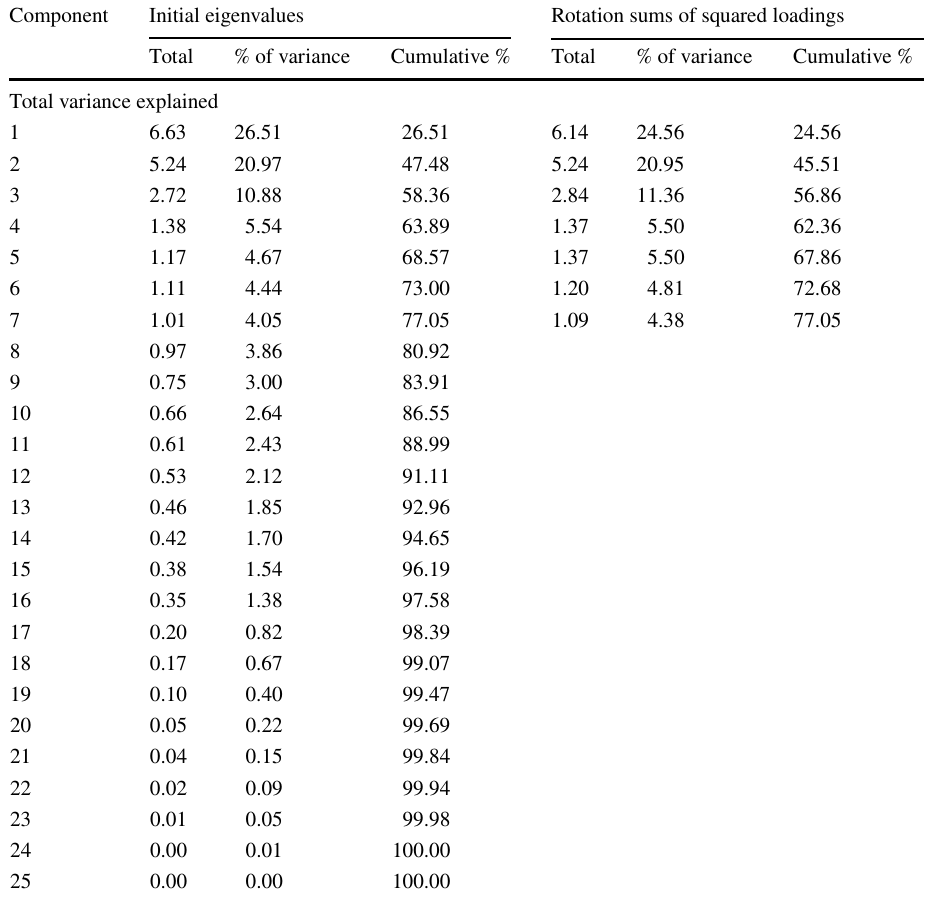
Extraction method: principal